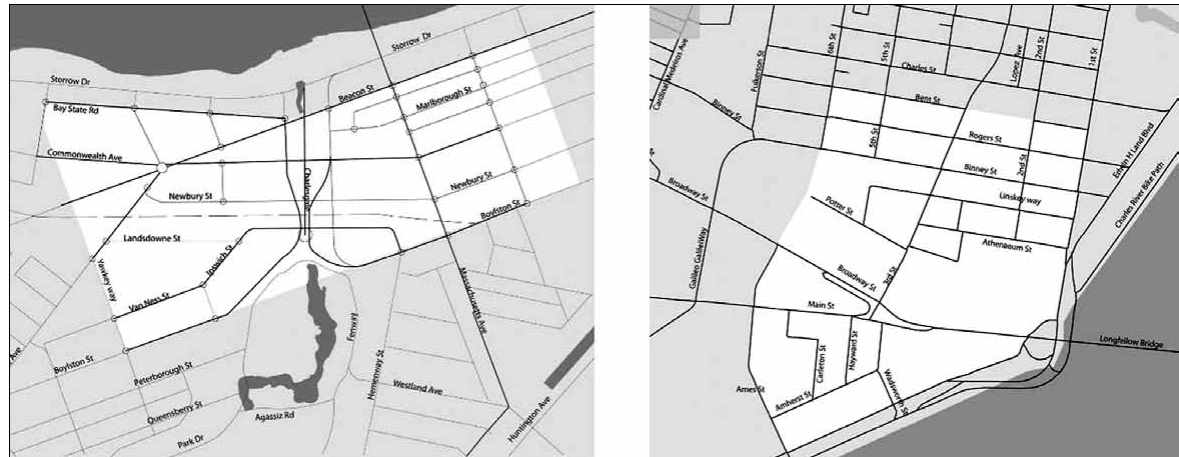
fig. 1. left: Kenmore and West Back Bay survey area / right: Kendall Sq. Survey